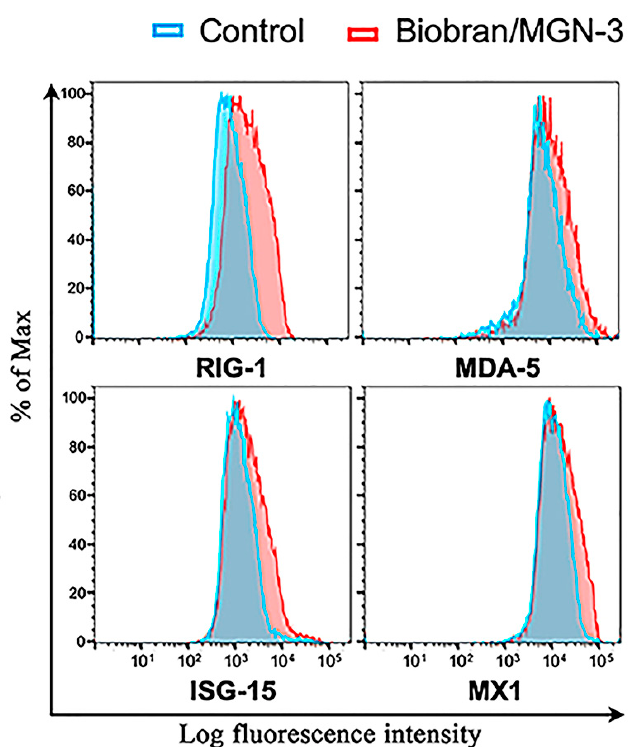
§ p -values represent comparison between post-treatment and baseline values and were determined using paired t-test because all data were normally distributed. All comparisons yielded non-significant differences between the post-treat- ment and the basal levels. ǂ Comparison between placebo and Biobran/MGN-3 groups yielded non-significant differences with regards to all variables. p ≤ 0.05 was considered statistically significant. RBC, red blood cell; Hb, hemoglobin; HCT, hematocrit; MCV, mean corpuscular volume; MCH, mean corpuscular hemoglobin; WBC, white blood cell; ALT, alanine aminotransferase; AST, aspartate aminotransferase; UA, uric acid.